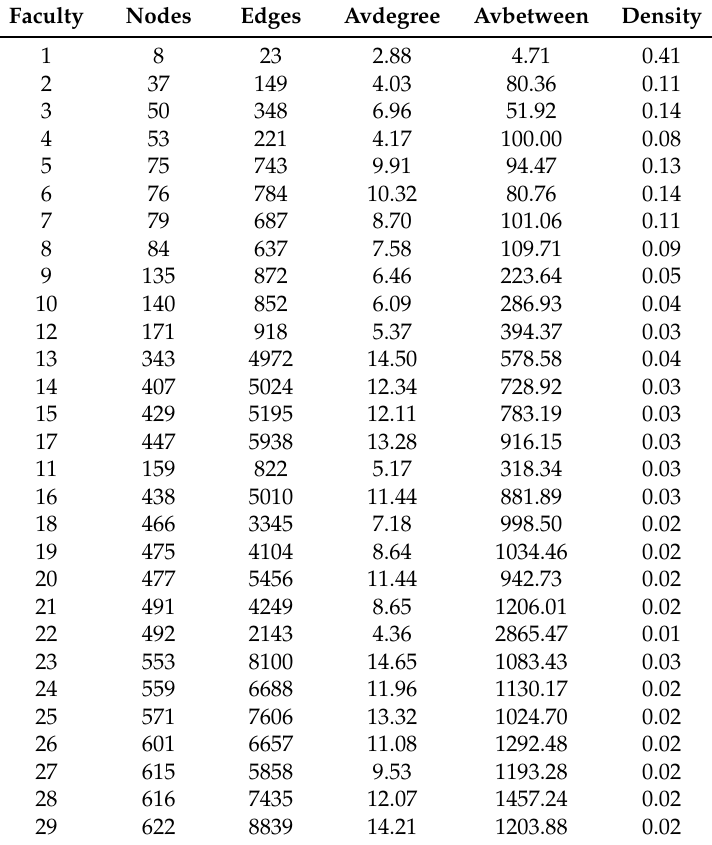
Table 1. Faculty network centrality